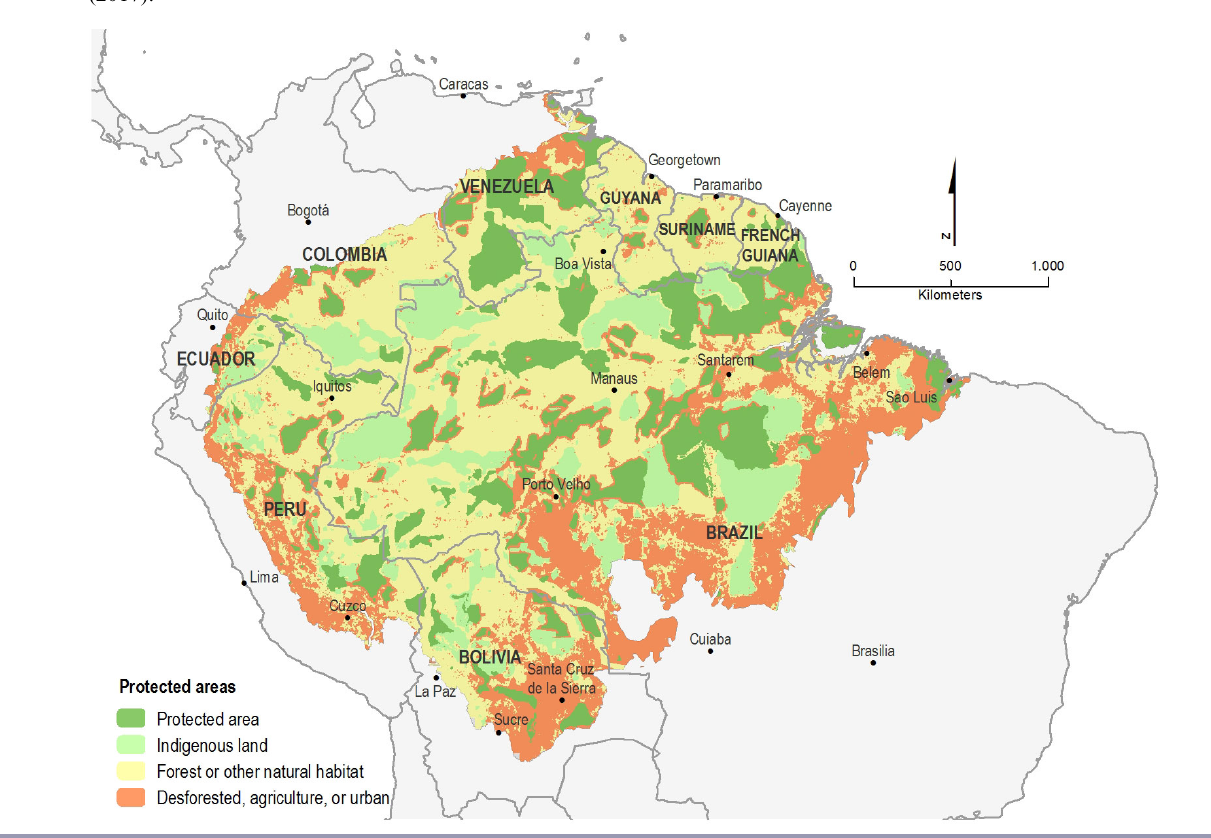
Fig. 2 . Current Amazonian situation, threats, and management forms. Source: Modified from Neugarten et al.